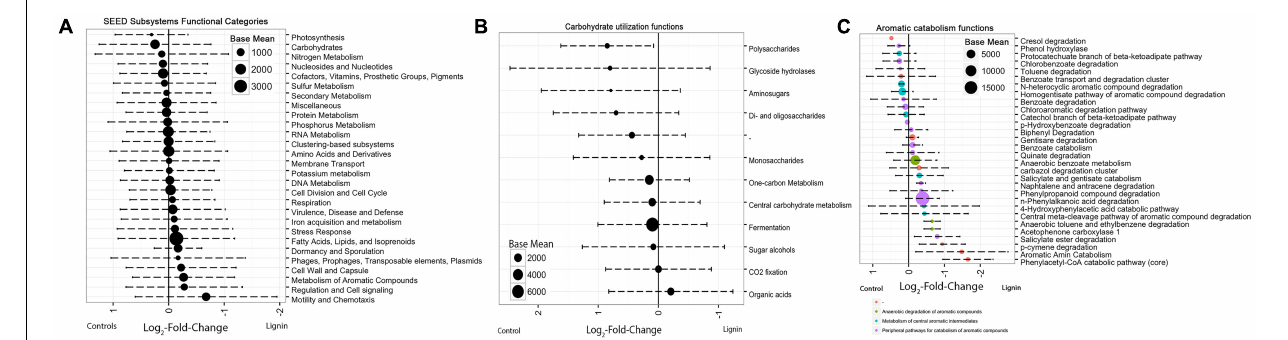
FIGURE 3 | Average log 2 -fold change of differentially abundant functional categories between the two lignin and two xylan microcosms. The log-fold change and base mean were determined by R package, DESeq2 . Base mean, as represented by the size of the point, is the average of the normalized counts over all samples. Categories are based on SEED Subsystems annotation. Positive log 2 -fold change indicates functions in higher abundance in lignin-amended microcosms. Negative log 2 -fold change indicates functions in higher abundance in xylan-amended microcosms. Error bars represent the standard deviation. (A) All functional categories, (B) only carbohydrate-related functions, and (C) only aromatic catabolism-related functions.